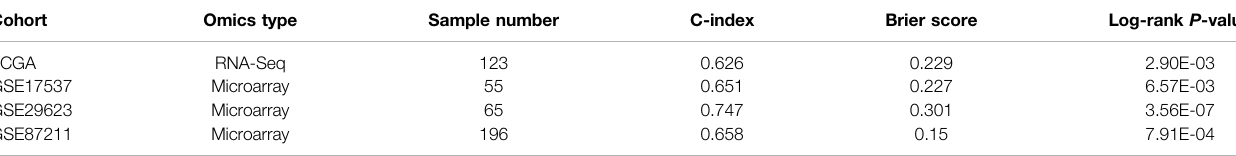
TABLE 2 | Performance of the gene signature in the test TCGA cohort and three external validation cohorts using all 11 features.